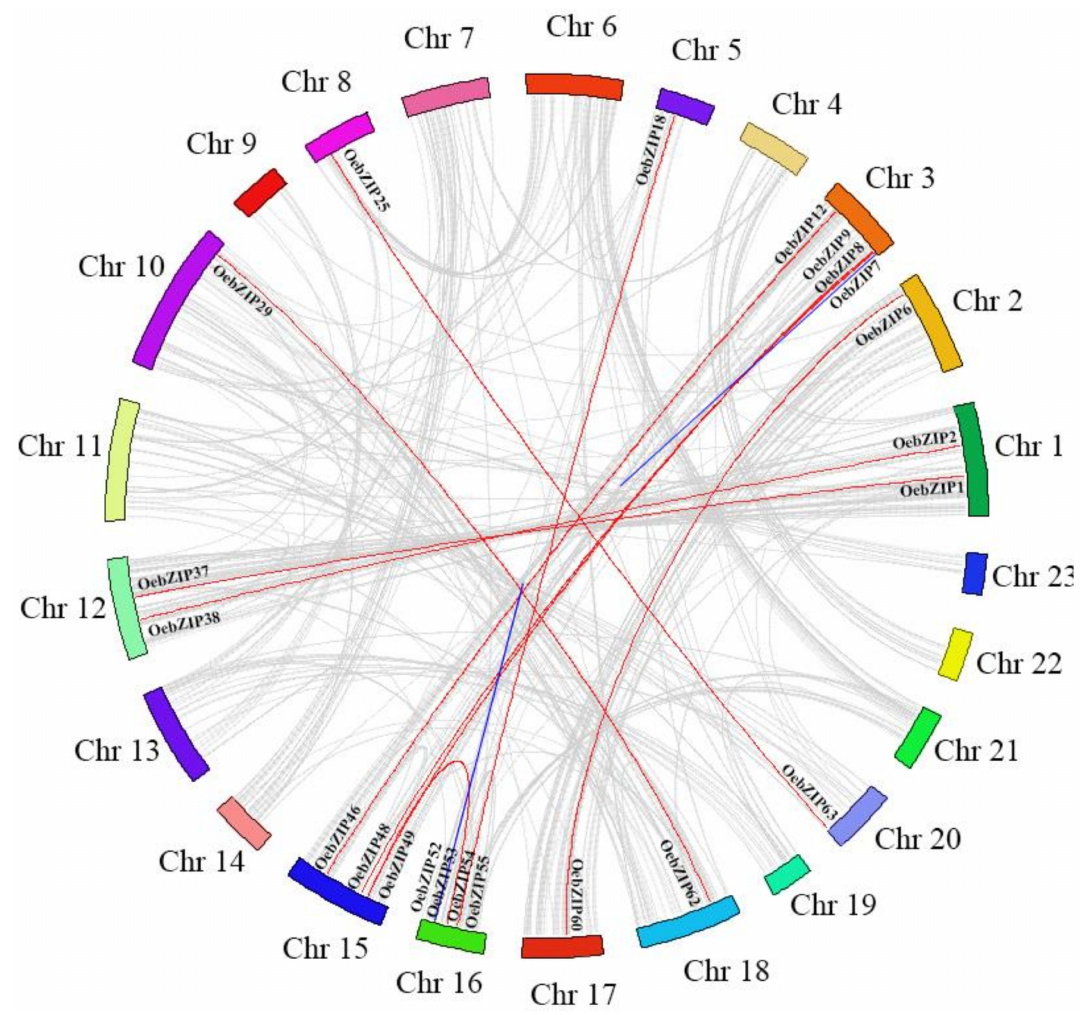
Figure 4. Gene duplication events in the OebZIP gene family. The OebZIP genes linked by the red line are the segment repeats, while the OebZIP genes linked by the blue line are the tandem repeats. Di ff erent color blocks represent di ff erent